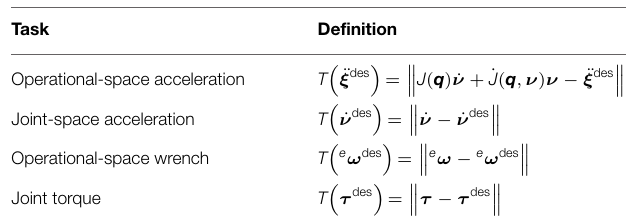
TABLE 2 | Different types of